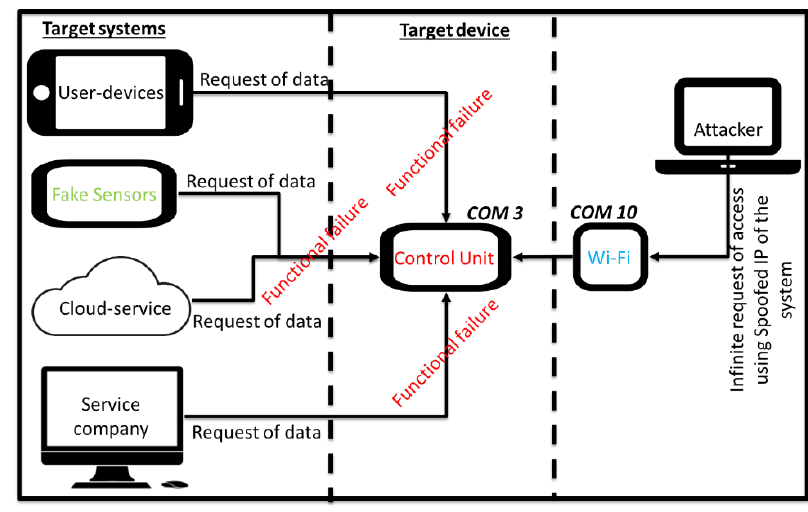
Figure 15. A DoS attack process.